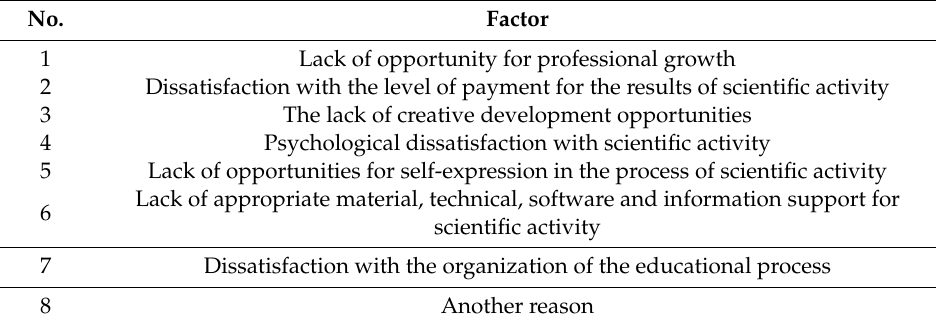
Table 3. Factors defining the performance indicators dynamics for scientific